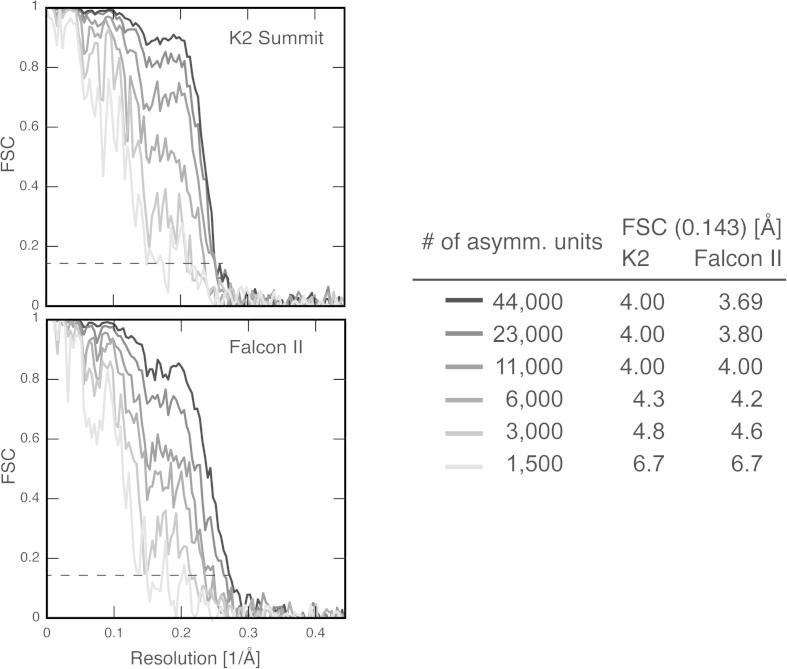
Comparison of Falcon II and K2 Summit structures computed with increasing number of asymmetric units. Left. Fourier-shell correlation curves from K2 Summit (top) and Falcon II (bottom) with increasing number of asymmetric units color-coded from gray to black. Right. Table of respective resolution cutoff values (0.143).